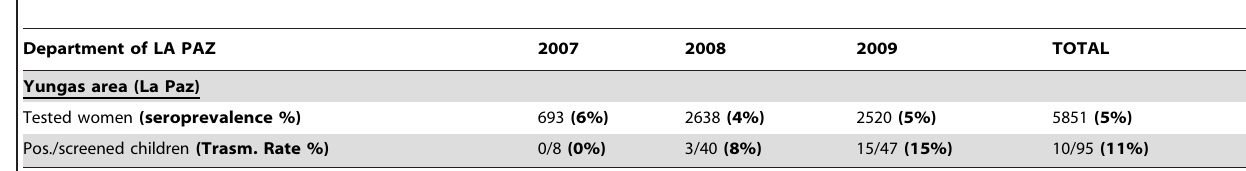
Table 8. Seroprevalence and maternal-fetal transmission rate in the La Paz health